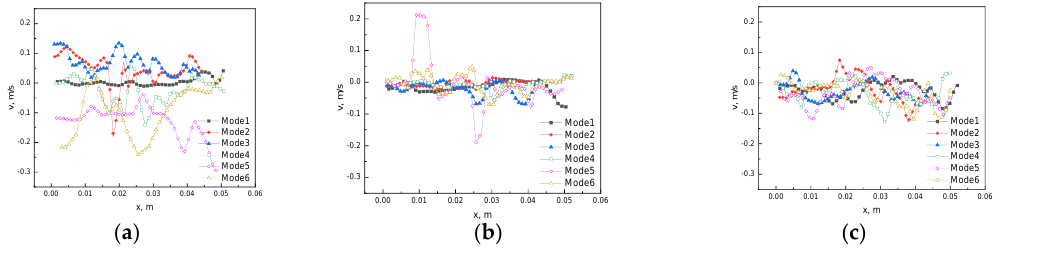
Figure 9. Vertical component of velocity at 1 mm below liquid surface in three physical forms of hydraulic jump (casting speed 2.4 m/min). ( a ) CHJ; ( b ) HJT; ( c ) SLL. In CHJ, with solidification, the horizontal component of velocity on the left side is negative, the horizontal component of velocity on the right side is positive, and the verti- cal component of velocity is mostly negative, which obviously forms the flow rushing to both sides of the wall and sputtering upward, combined with Figures 2 – 5 (the velocity is also obtained by software PIVlab processing the information of the photos) ; without solidification, most modes have already begun to form backflow to the cen- ter of the mold. This is because solidification increases the resistance to flow and slows the progress of the hydraulic jump. After CHJ, the velocity decays rapidly. In order to better illustrate the effect of the solid – liquid interface morphology on the hydraulic jump behavior (including height and duration), the results of the control exper- iments without solidification are given in Figures 10 – 12. The liquid-level height of different modes at two different casting speeds with or without solidification in three hydraulic jump forms is shown in Figure 10. It can be seen that the average liquid-level height in SLL increases with the increase in the casting speed in general, and the liquid-level height in HJT has little relationship with the mode and solidification.